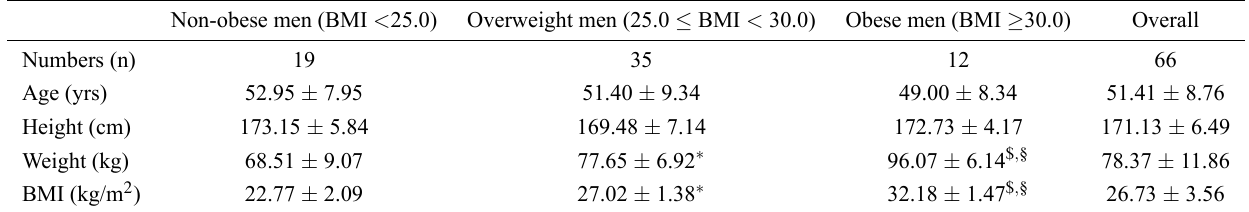
Table 1. Description of characteristics of the study